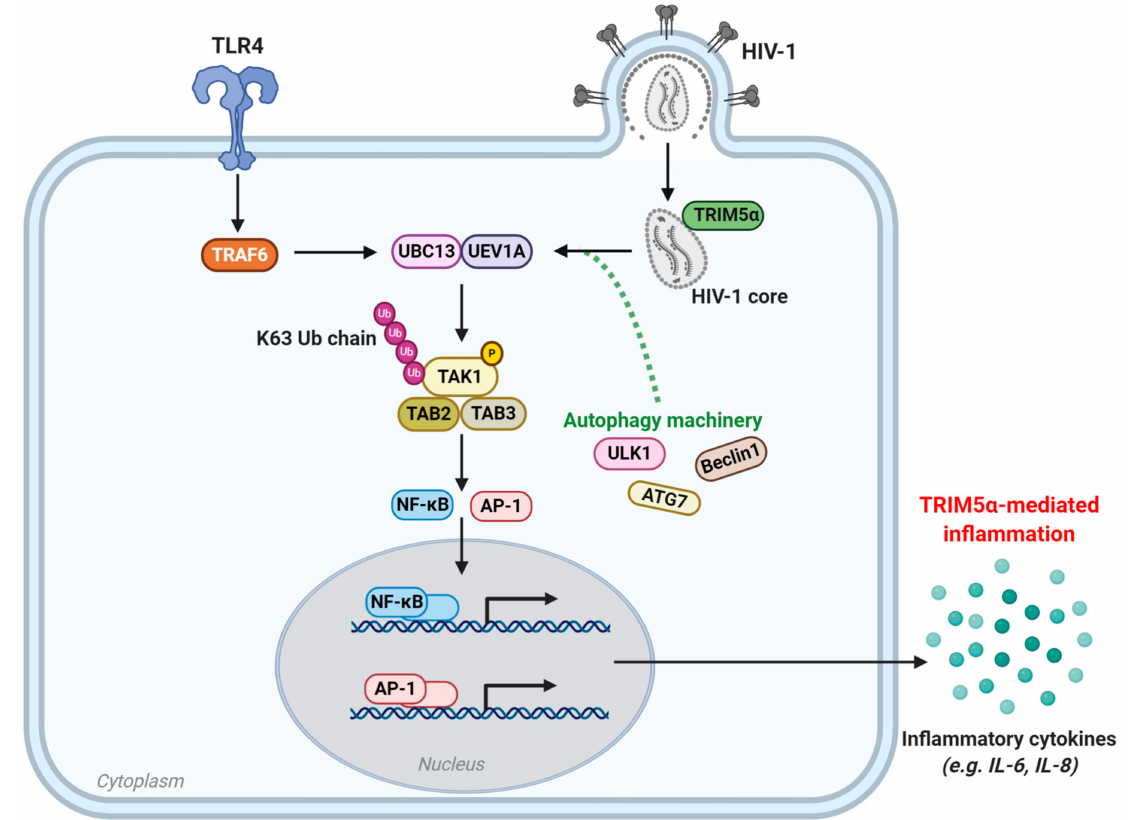
Figure 3. TRIM5 α -mediated regulation of innate immune signaling and molecular inflammation. The TAK1 signaling pathway is activated upon TLR4 stimulation, or upon sensing of viral capsid by TRIM5 α . Subsequently, the E3 ligase activity of TRAF6 is activated and, together with the E2 ubiquitin conjugating enzyme complex UEV1A-UBC13, promotes K63-chain linked ubiquitination and autophosphorylation of the TAK1-TAB complex. In the context of HIV-1 infection, sensing of the viral capsid by TRIM5 α initiates its E3 ligase activity resulting in K63-chain linked ubiquitination and autophosphorylation of the TAK1-TAB complex. Subsequently, the TAK1-TAB complex activates the transcription factors NF-kB and AP-1, leading to the transcription and ultimately secretion of pro-inflammatory cytokines such as IL-6 and IL-8. The autophagy-related proteins ULK1, Beclin1 and ATG7 are essential for TRIM5 α to function as an innate immune sensor. However, precisely how they contribute to the TRIM5 α -mediated inflammation is as yet uncertain. TLR4: toll-like receptor 4, TAK1: transforming growth factor- β -activated kinase 1, TAB: TAK1-binding protein, UEV1A: ubiquitin-conjugating enzyme E2 variant 1A, UBC13: ubiquitin-conjugating enzyme E2 13, AP-1: activating protein 1, NF- κ B: nuclear factor κ B, Ub: ubiquitin, P: phosphate, IL: